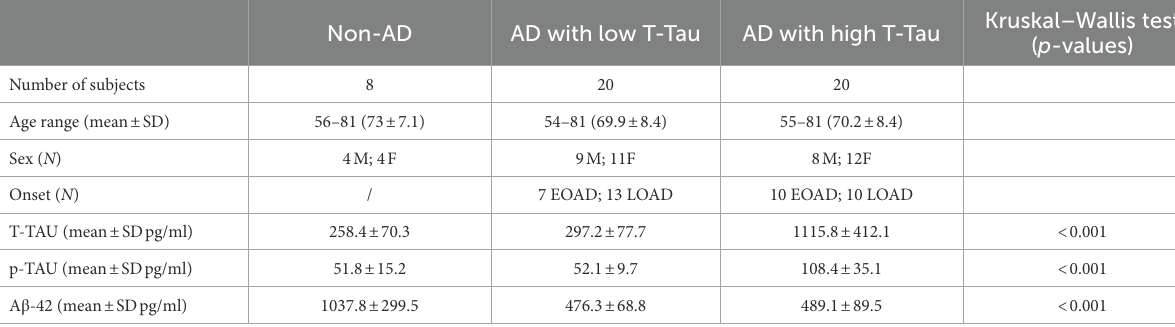
TABLE 1 Cerebrospinal fluid (CSF) sample